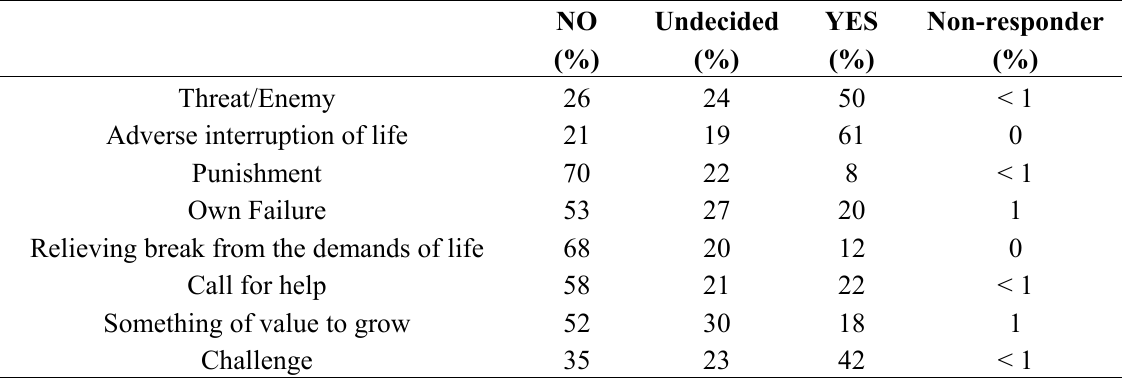
Table 2. Interpretations of Illness (multiple answers).